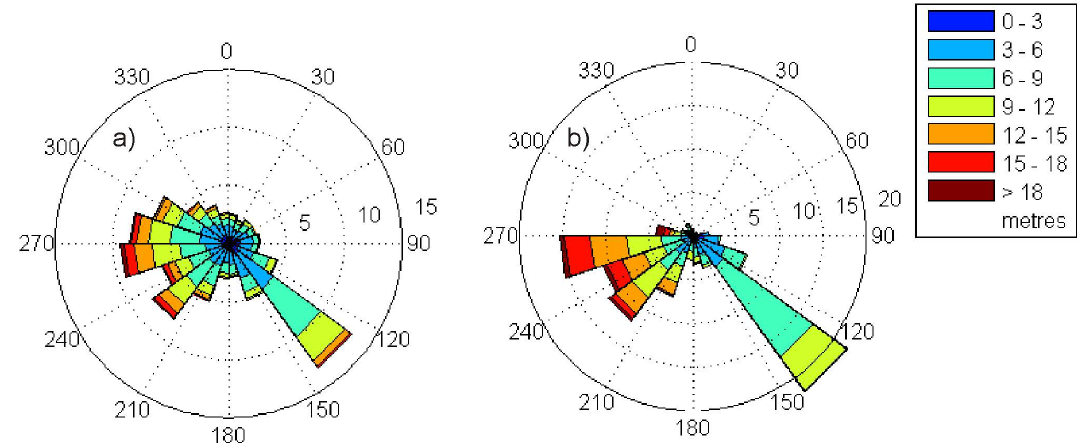
Fig. 1. Wind Roses from the Hilbre Island Met station for (a) 2005–2012 and (b) the study period.